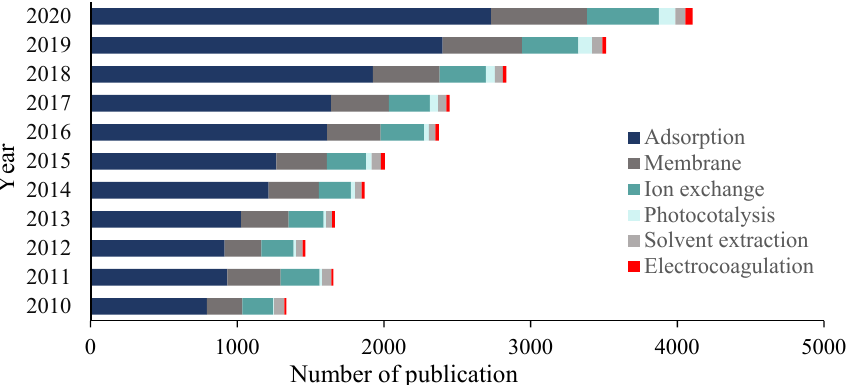
Figure 1. Publications on the removal of heavy metals via different techniques from 2010 to 2020, based on the Scopus database.